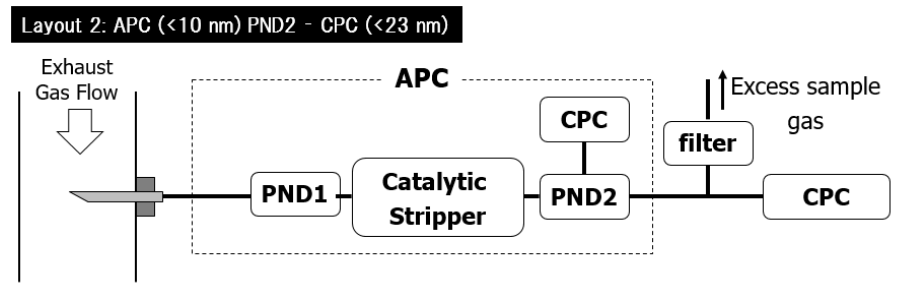
Figure 4. Considered measurement layout consisting an APC and a CPC. APC = AVL Particle Counter; CPC = Condensation Particle Counter; PND = Particle Number Diluter .